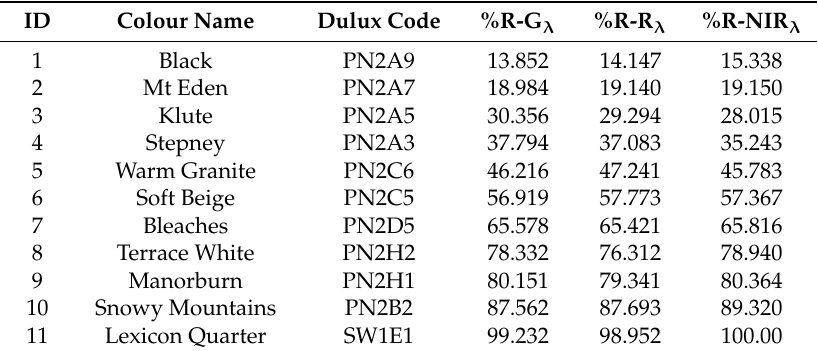
Table 3. Dulux colour card IDs and measured mean spectral reflectance values 1 .